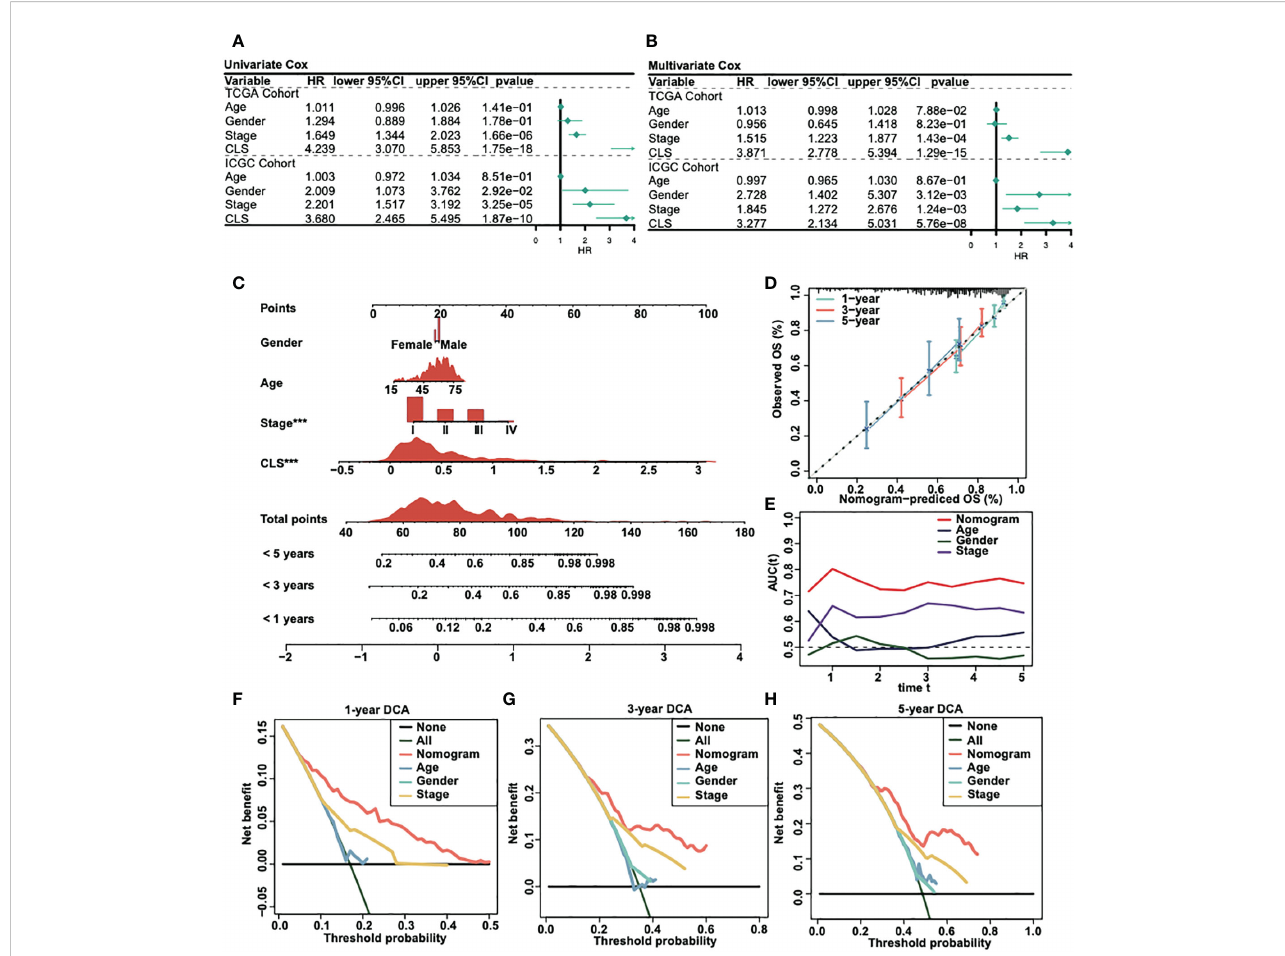
FIGURE 3 Construction of a CLS-based nomogram. (A) Univariate Cox regression in TCGA and ICGC cohorts. (B) Multivariate Cox regression in TCGA and ICGC cohorts. (C) Construction of a nomogram by various parameters. (D) Calibration curve of the CLS-based nomogram. (E) AUC analysis for the constructed nomogram. (F) One-year DCA for the nomogram. (G) Three-year DCA for the nomogram. (H) Five-year DCA for the